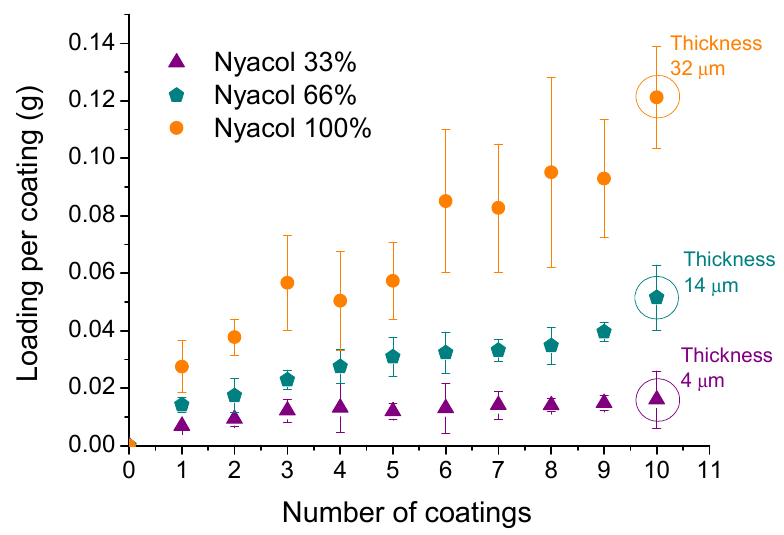
Figure 5. Weight gain of Al 2 O 3 per coating of the printed plates.